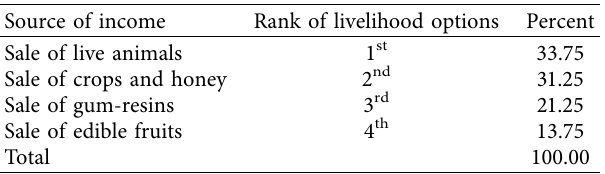
Source: field survey (2018/19). Table 2: Livelihood options and income sources in study area (respondents � 80) in South Omo